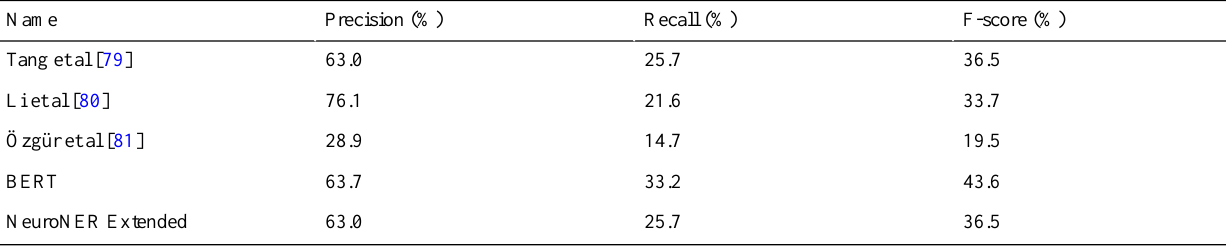
Table 17. Task 1B Wikipedia cue-level detection